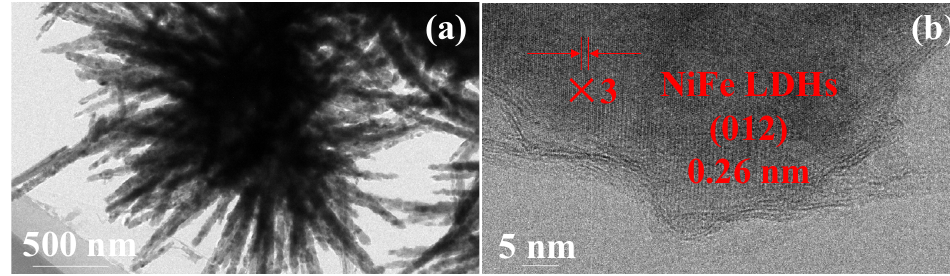
Figure 3. TEM images of the NiFe LDHs ( a , b ).